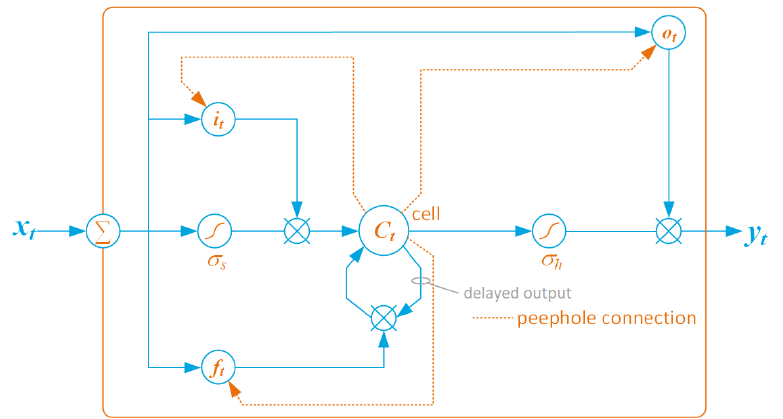
Figure 8. Detailed schematic of a basic LSTM cell (dotted lines denote peephole connections). In its basic implementation, the LSTM is formed by three gates (the input gate i t , the forget gate f t , and the output gate o t ), a block input activation function σ s , an output activation function σ h and a single cell C t (the Constant Error Carousel (CEC)). Function σ s is a sigmoid, whereas σ h is usually a hyperbolic tangent. Moreover, cell C t has a hyperbolic tangent activation function denoted with σ c